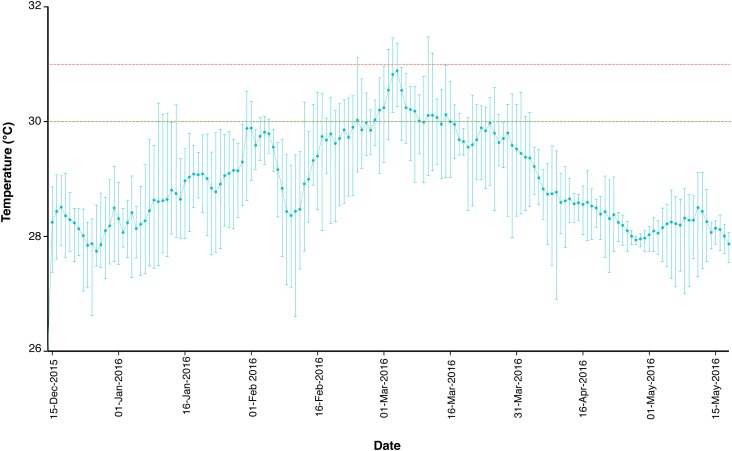
Temperature profile of the reef flat of Yonge Reef, on the GBR, Australia, between December 15, 2015 and May 15, 2016. Green and red dashed lines represent 30 and 31°C threshold, respectively. Data are expressed as mean, maximum and minimum daily temperature values. Data available at: http://data.aims.gov.au.